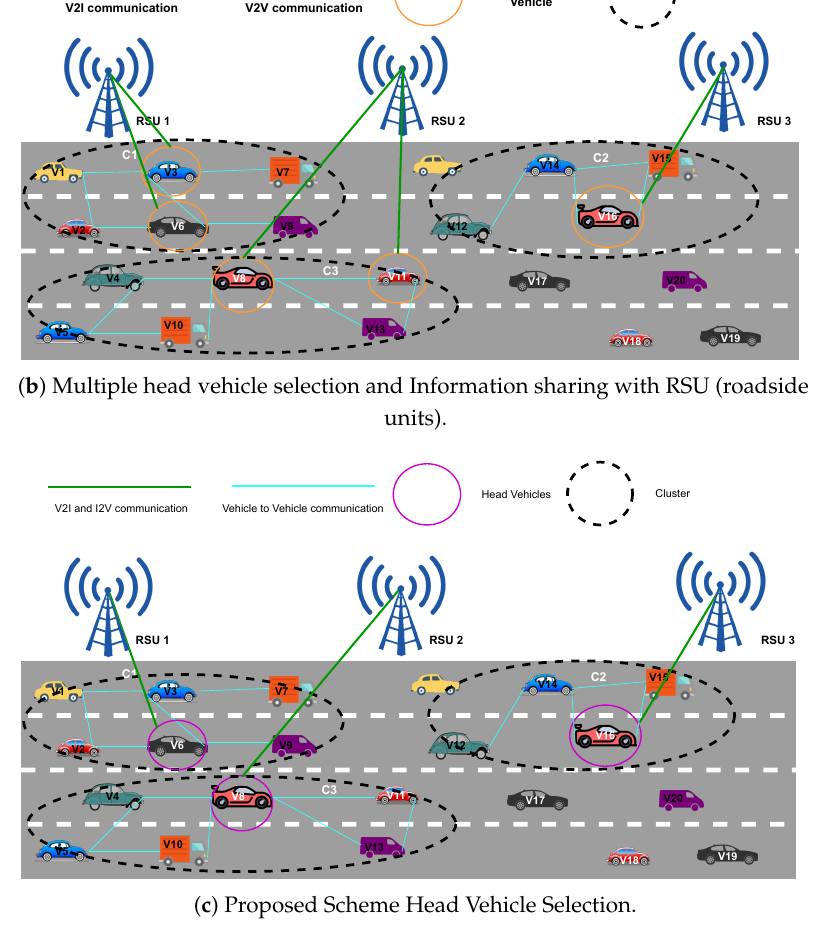
Figure 4. Multihead Selection Scheme working.